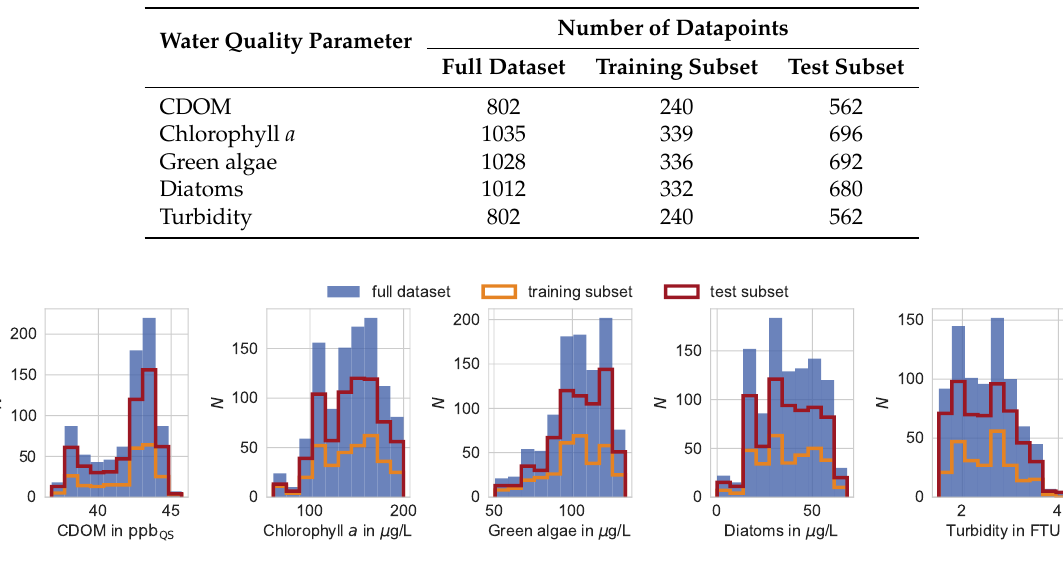
Figure 3. Distributions of the water quality parameter values. Each full dataset (blue bars) is split randomly into a training (orange) and a test (red) subset. The number of datapoints is symbolized as N .